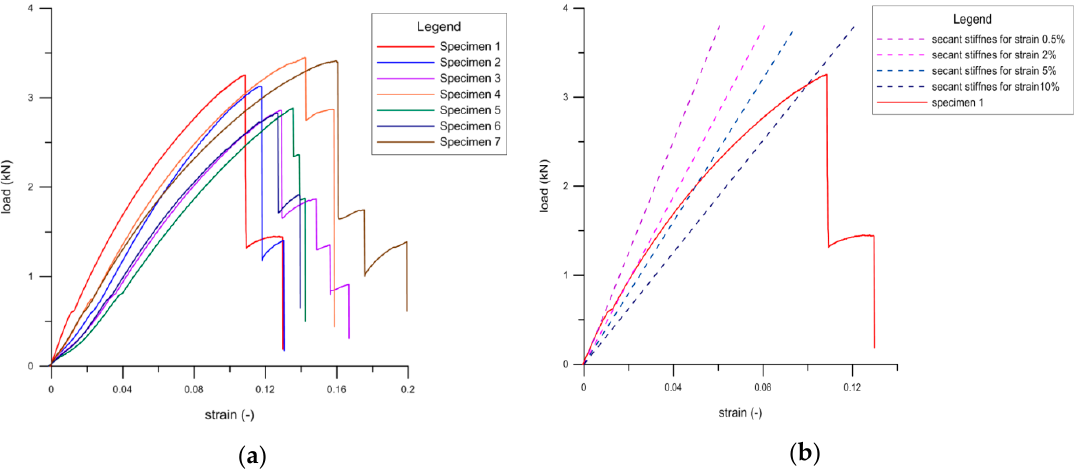
Figure 22. Polypropylene geogrid samples: ( a ) Load-strain curves; ( b ) secant sti ff ness lines [38].